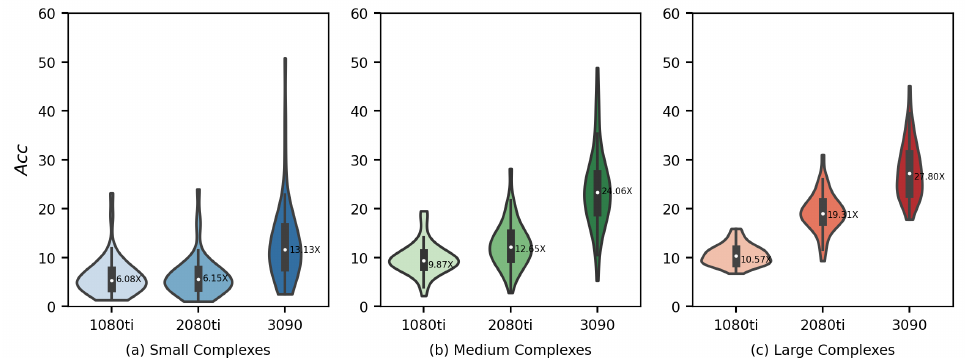
Figure 6. Acceleration of docking time ( Acc ) of our Vina-GPU against AutoDock Vina on three different GPUs and various scales of complexity (small—5–23 atoms, medium—24–36 atoms, large— 37–108 atoms). 1080ti—NVIDIA Geforce GTX 1080ti; 2080ti—Nvidia Geforce RTX 2080Ti; 3090— Nvidia Geforce RTX